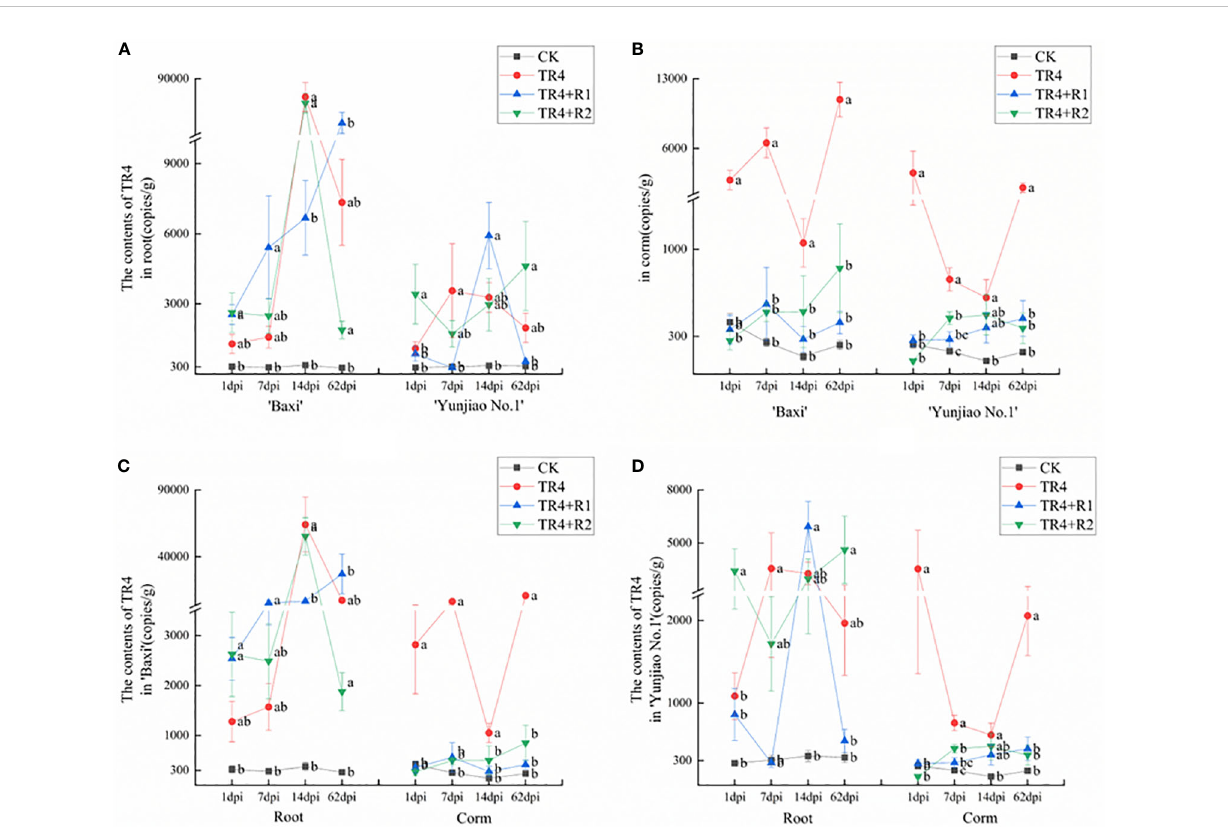
FIGURE 4 Biomass of TR4 in different tissue of banana cultivars at different time points after TR4 inoculation. (A) Differences of TR4 content in two cultivars in roots; (B) Differences of TR4 content in two cultivars in corms; (C) Differences of TR4 content in different tissue in ‘ Baxi ’ ; (D) Differences of TR4 content in different tissue in ‘ Yunjiao No.1 ’ . The data represents three independently repeating values. Based on Duncan ’ s multiple range test, a signi fi cant difference was determined at P <0.05. Lowercase letters a, b, c, d mark signi fi cant differences: the same letter means no difference during the same period, while different letters indicate a signi fi cant difference. Error bars represent ± standard